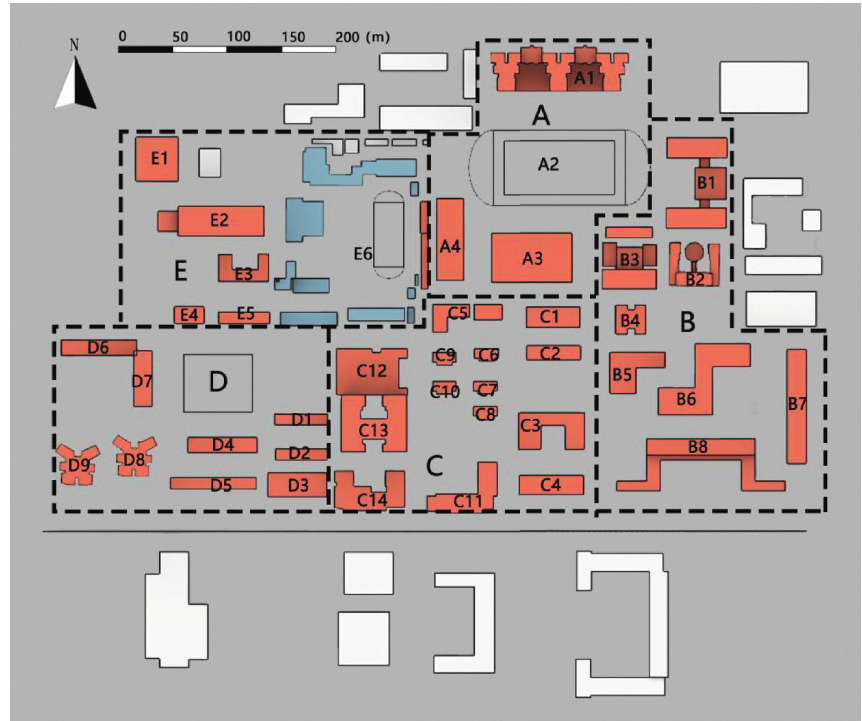
Figure 1: The subregion description of CUMTB